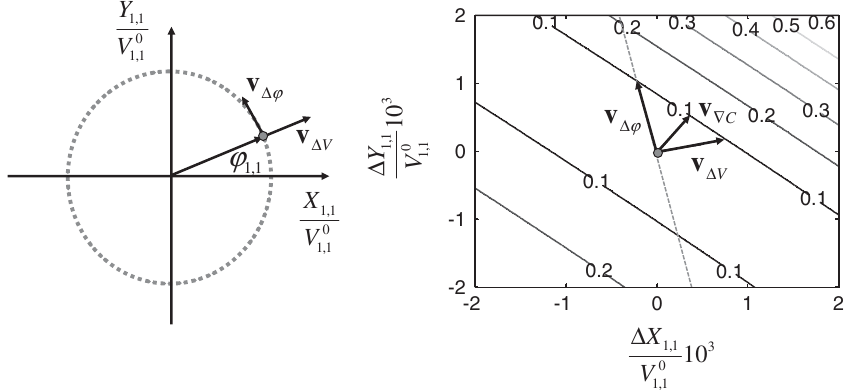
Þ . The contour plot at the ; Y 11 11